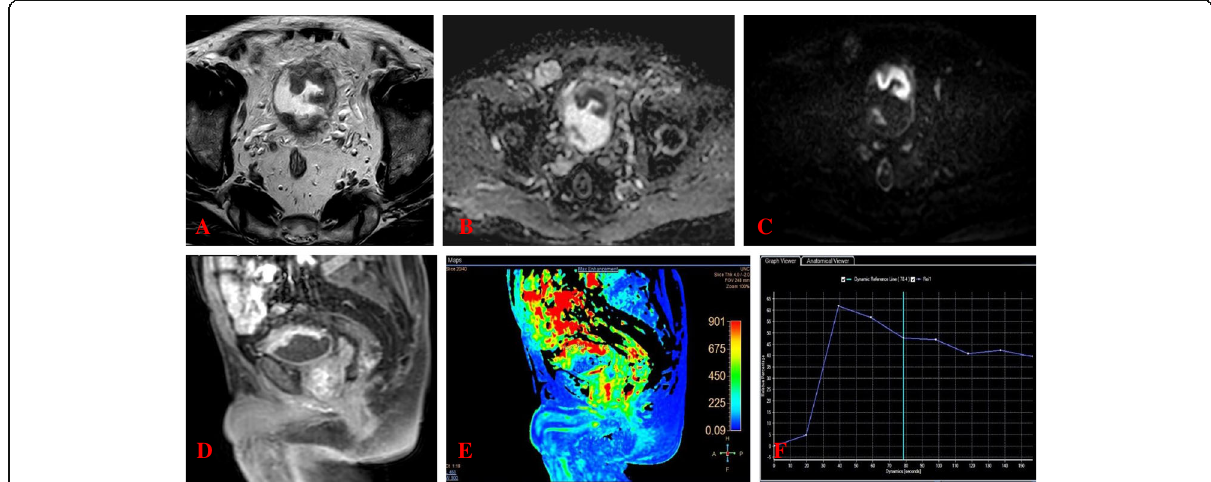
Fig. 5 A 64-year-old male patient presented with history of recurrent hematuria. Axial T2 WI ( a ) showed an intra-vesical soft tissue mass arising from bladder dome and left lateral wall expressing intermediate signal intensity with interruption of the hypointense underlying muscle layer and no obvious infiltration of the perivesical fat. Axial ADC map ( b ) showed low SI of the lesion with ADC value = 0.7 × 10 − 3 mm 2 /s, consistent with high-grade tumor. Axial DW-MRI (b1000) ( c ) showed restricted diffusion of the mass with invasion of the muscle layer. Sagittal post contrast T1WI FAT-SAT image ( d ) showed early enhancement of the mass with focal involvement of underlying muscle layer. Perfusion image ( e ) and time- intensity curve ( f ) showed grade 3 curve with early enhancement and rapid washout. The patient underwent radical cystectomy, and the histopathology was high-grade adenocarcinoma; MP-MRI features suggest high-grade stage T2 muscle-invasive urinary bladder carcinoma, and histopathological assessment confirmed the diagnosis